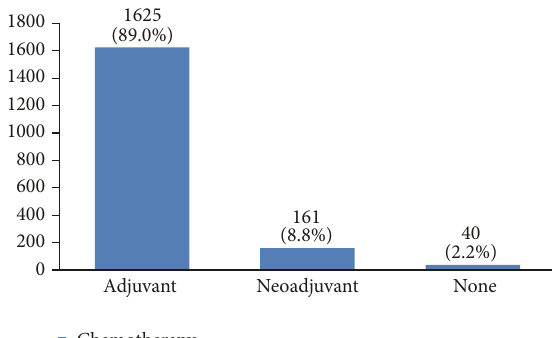
Figure 26: The percentage of estrogen receptor in the studied cases.